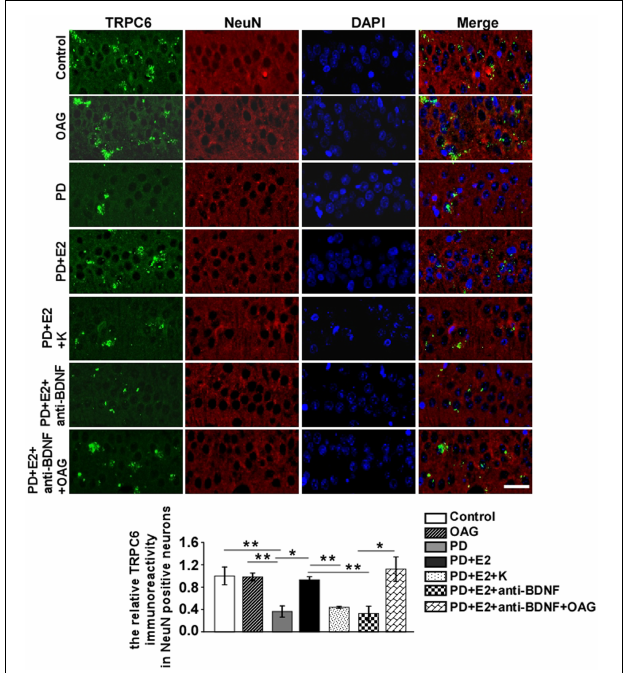
FIGURE 10 | K252a or anti-BDNF administration significantly inhibited the upregulation of TRPC6 expression in the hippocampal CA1 area in PD rats treated by E 2 ; further co-treatment of TRPC6 agonist blocked the above effects. Immunofluorescent micrographs showing the changes in fluorescence intensity of TRPC6 in NeuN-labeled neurons in the CA1 region of the hippocampus in the control group, OAG group, PD group, PD + E 2 group, PD + E 2 + K group, PD + E 2 + anti-BDNF group, and PD + E 2 + anti-BDNF + OAG group. The relative immunoreactivity of TRPC6 in neurons was quantified ( n = 5, each group). Data are presented as means + SEM. * p < 0.05; ** p < 0.01. Scale bar = 30 µ